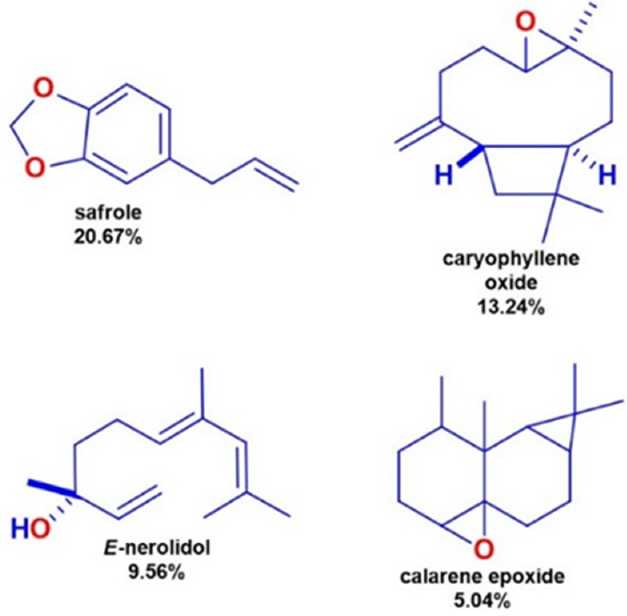
Figure 2. The major essential oil obtained from Piper cordoncillo essential oil.